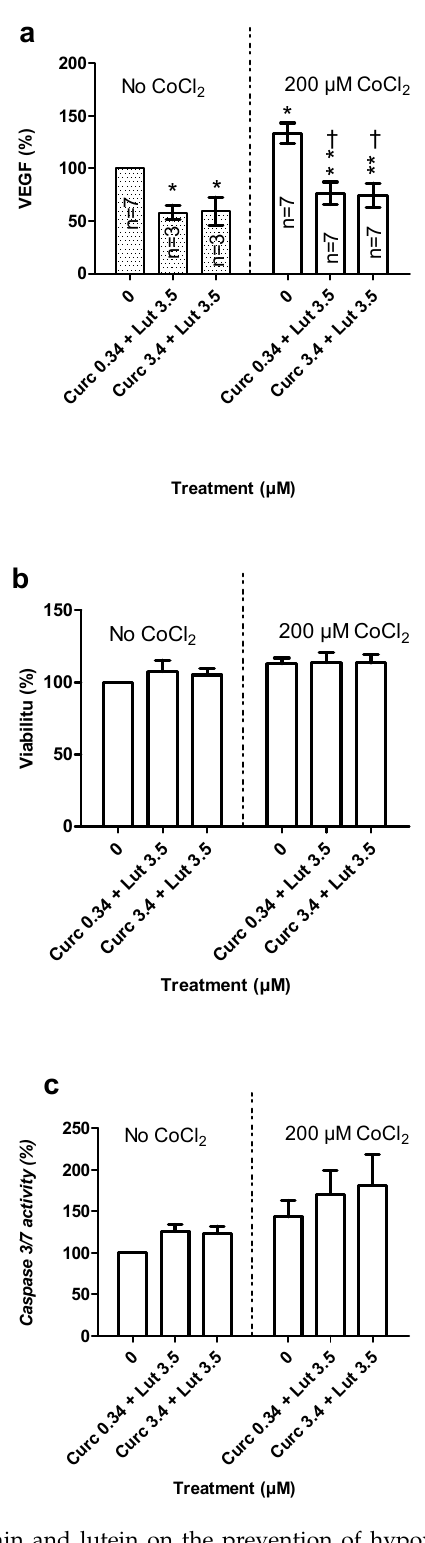
Figure 10. E ff ect of curcumin and lutein on the prevention of hypoxia-induced VEGF secretion. ARPE-19 cells were treated or untreated with curcumin + lutein for 24 h before induction of hypoxia with CoCl 2 at 200 µ M for 4 h. ( a ). VEGF quantification by ELISA in supernatants. ( b ). Cell viability and ( c ). caspase 3 / 7 activity ( n = 4, triplicates per group). Results are expressed as mean % ± SEM. Statistical significance (*) compared to No-CoCl 2 -No-pretreatment or ( † ) compared to CoCl 2